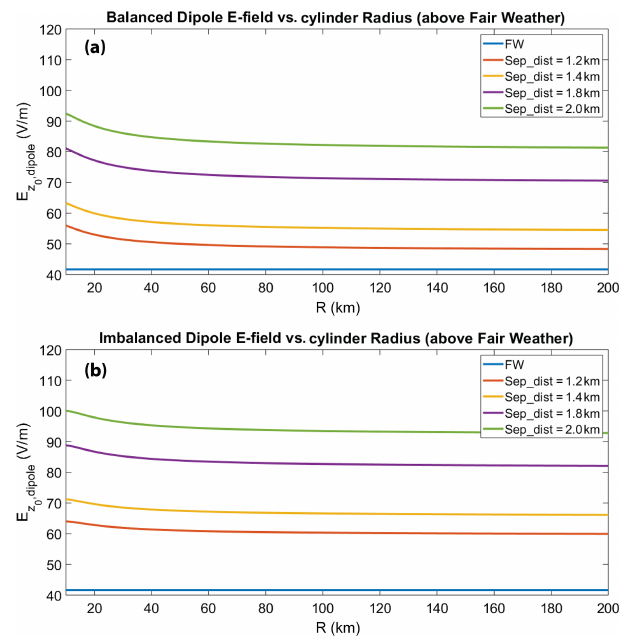
Figure 5. Vertical electric field strength at ground level ( E z above the fair-weather field (blue line), for a dipole of (a) finite uni- formly charged cylinders and (b) non-uniformly charged cylinders exhibiting a charge imbalance of 8%, within an elevated dust layer as a function of the cylinder radius R . E z separation distances (Sep_dist) of 1.2, 1.4, 1.8 and 2km between the two charged